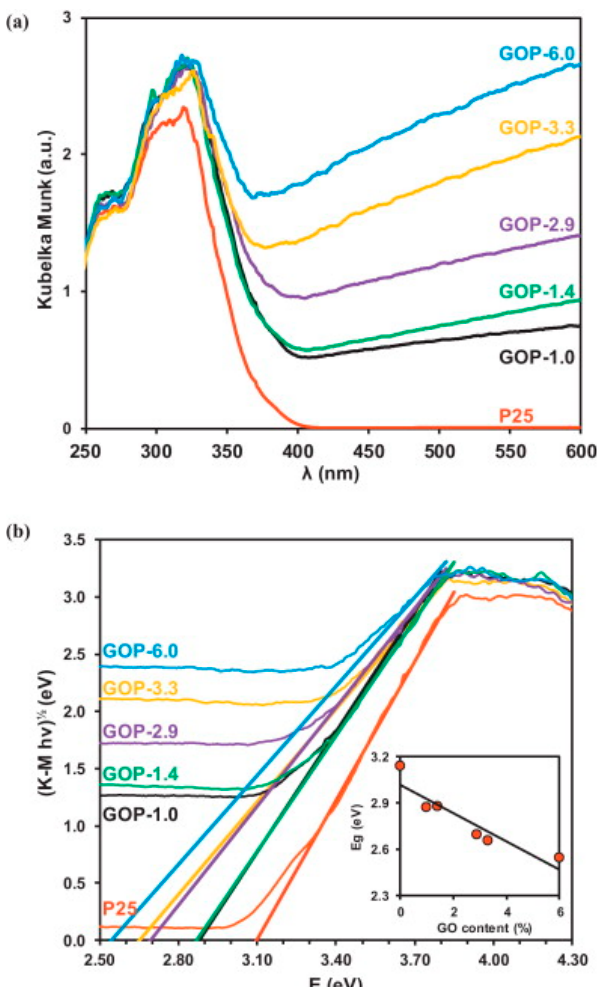
Figure 18. An example of the effect of the GO content on the UV–Vis absorption spectra (equivalent absorption Kubelka–Munk units) of TiO 2 /GO nanocomposites, and calculated band gap (in eV). Part ( a ) shows the transformed spectra of bare TiO 2 (P25) and those of the synthesized nanocomposites as a function of increasing the GO content (1 to 6 wt%). Part ( b ) shows the relationship between the transformed Kubelka–Munk function and the energy of absorbed light. The effect of GO content on the band gap energy is shown in the inset. Reprinted with permission from reference [123]. Copyright 2013